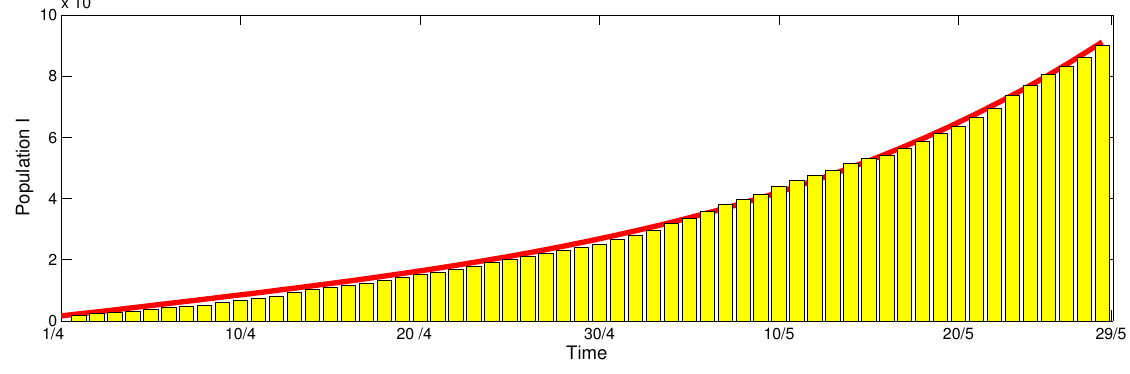
Fig. 3. Time series of infected population with parameter values and initial conditions from Table 1 and 2 during 1 / 4 / 2020 to 29 / 5 / 2020 .